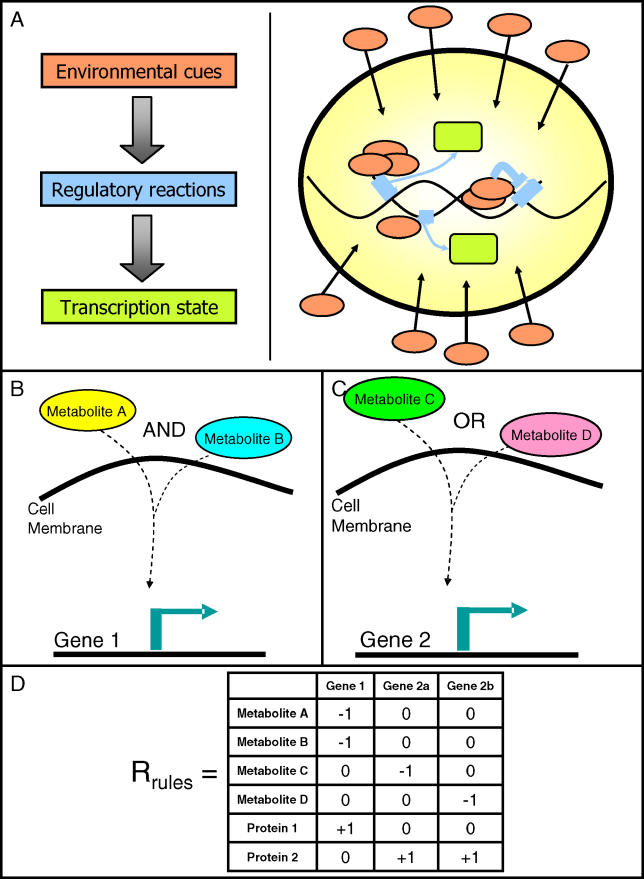
The Formation of the TRN Matrix(A) Depicts the TRS as a biological system consisting of inputs, internal reactions, and outputs. The inputs are environmental cues, including the presence and absence of metabolites, reaction fluxes, and specific conditions. The internal reactions are the regulatory rules that describe the activation or inhibition of gene transcription. The output is the transcription state, which is a collection of the protein products that result through a combination of the environmental cues acting upon the regulatory rules.(B) Depicts a situation where the presence of both of two metabolites is required for the expression of Gene 1.(C) Depicts a situation where the presence of either of two metabolites leads to the expression of Gene 2.(D) The associated regulatory network matrix (Rrules) represents each of these two regulatory rules of the sample TRN in quasi-stoichoimetric formalism. Gene 1 requires the presence of Metabolite A and Metabolite B, and the output of the reaction is the associated protein. Gene 2 requires either Metabolite C or Metabolite D, and the product is the associated protein. The rule associated with the activation of Gene 2 can be satisfied with two independent conditions. Thus, there are two columns corresponding to the activation of Gene 2.